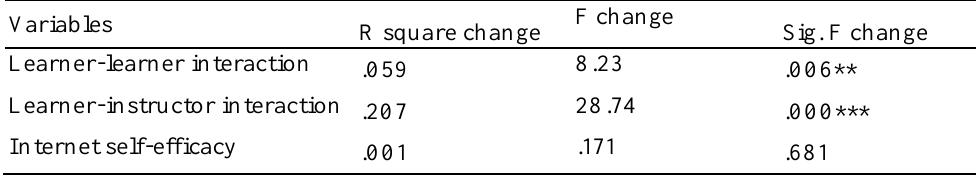
Unique Contribution of Each Predictor